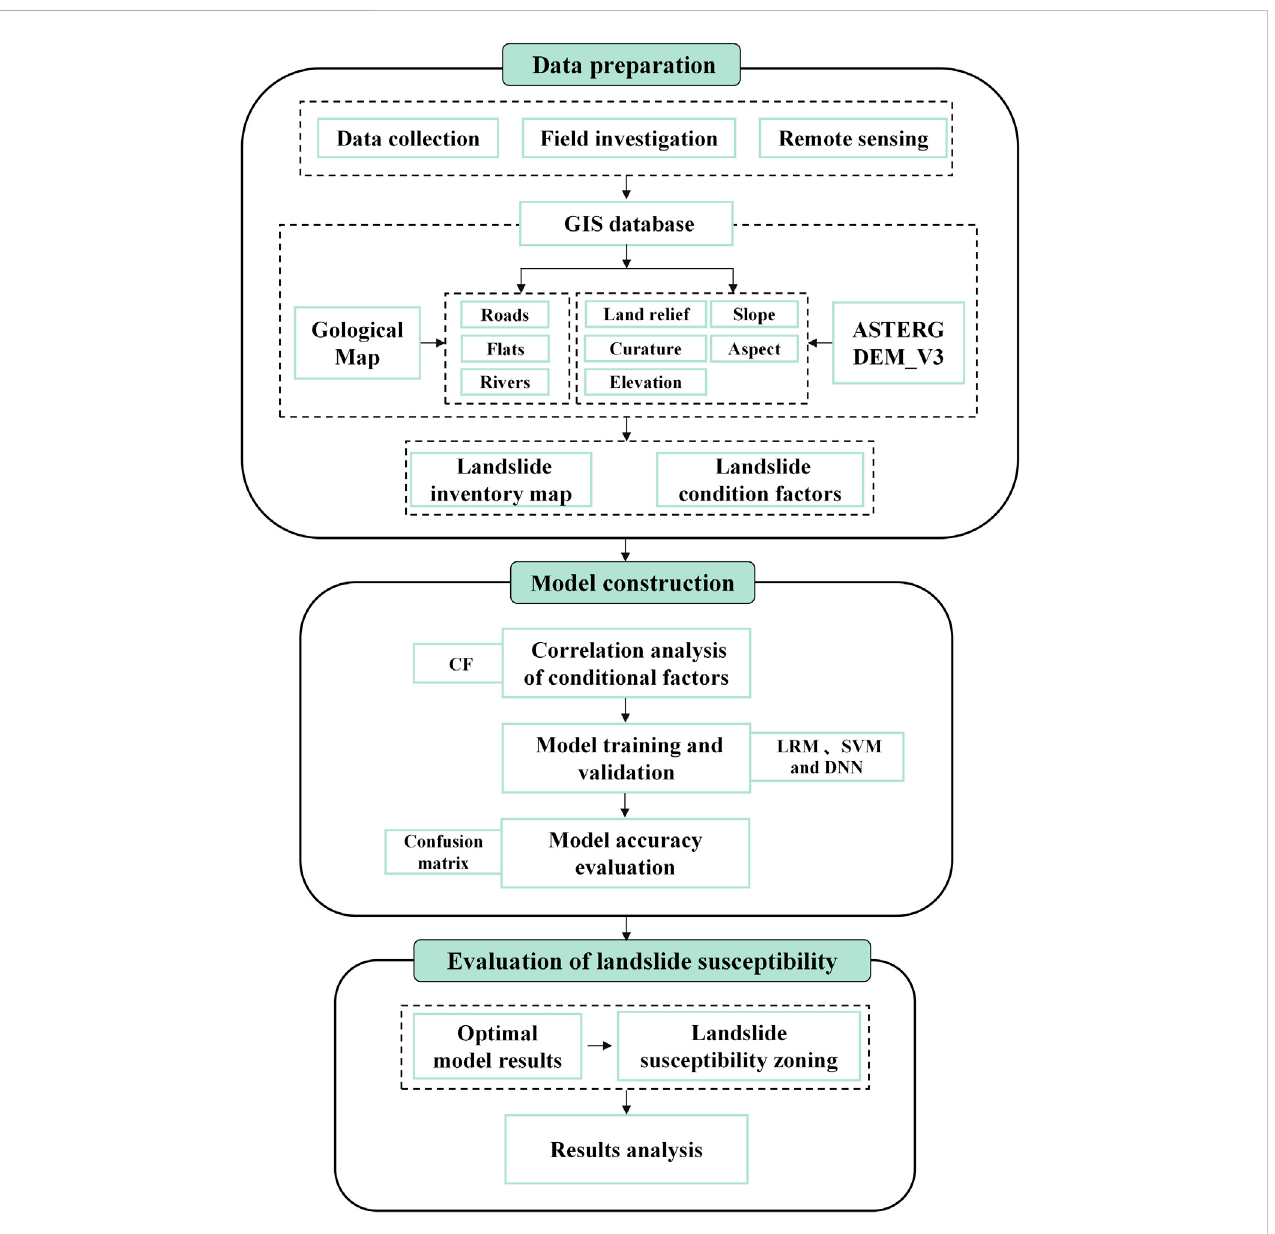
FIGURE 3 Work fl ow of the landslide susceptibility assessment conducted in this